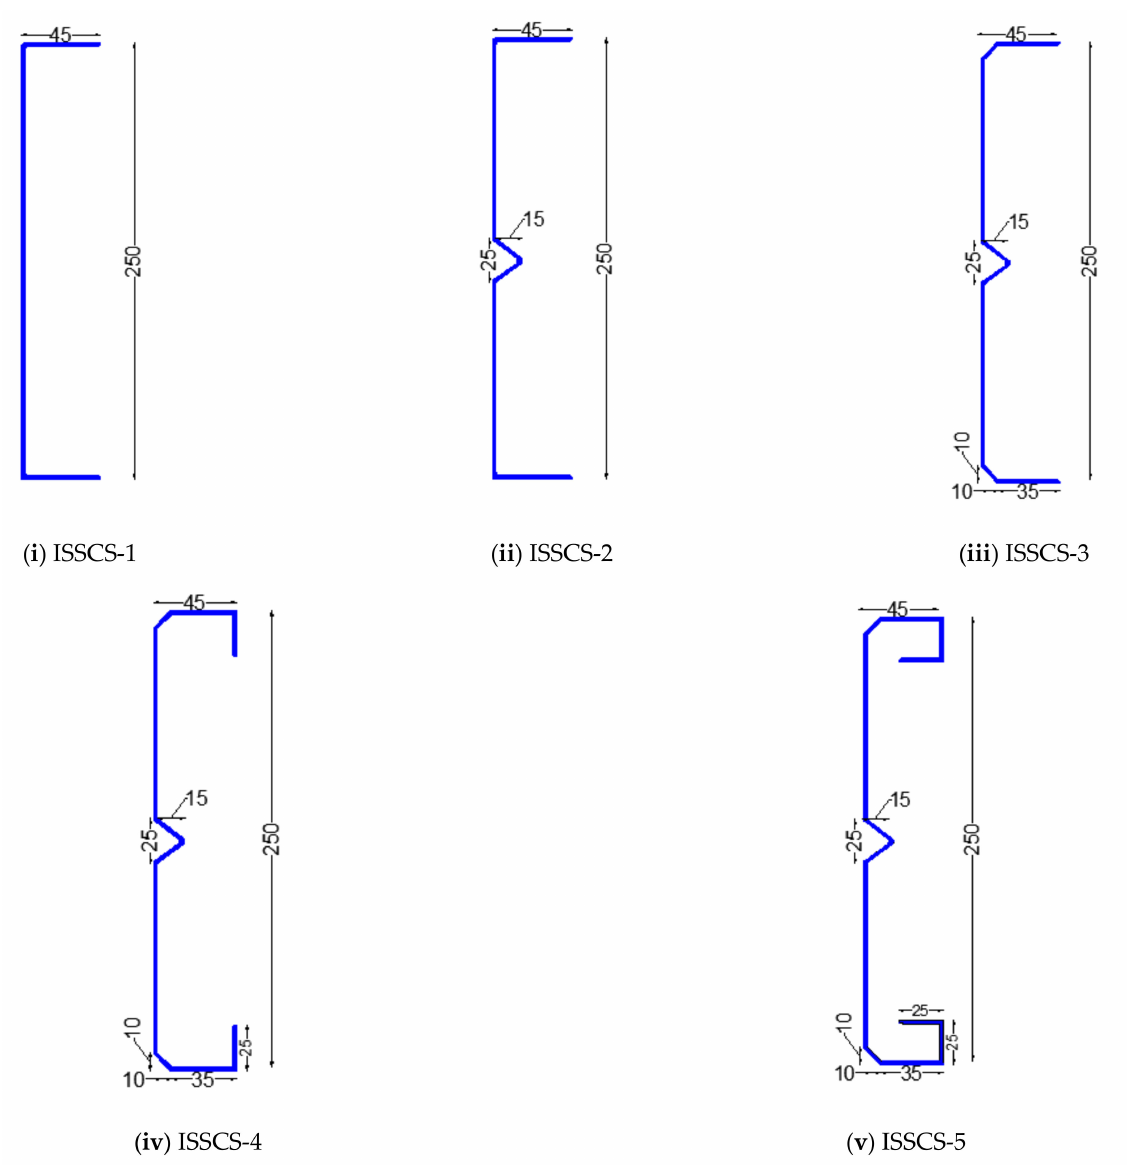
Figure 2. Cross-sectional details of intermediate stiffened single-channel sections (ISSCS). (All the dimensions are in